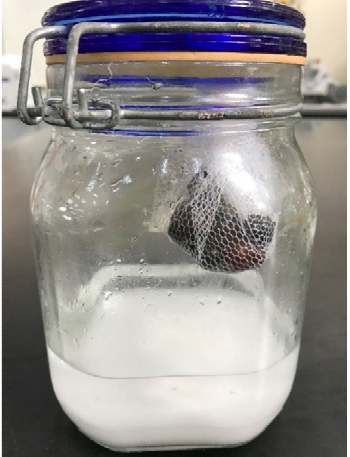
Figure 1. A sealed glass jar used in the experiments.